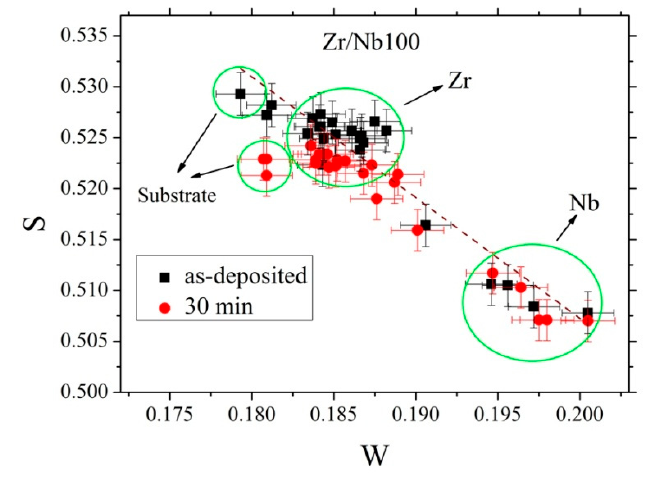
Figure 10. Dependence of S = f(W) for irradiated and as-deposited Zr/Nb 100. The dashed line indicates the approximating curve S = 0.744–1.185